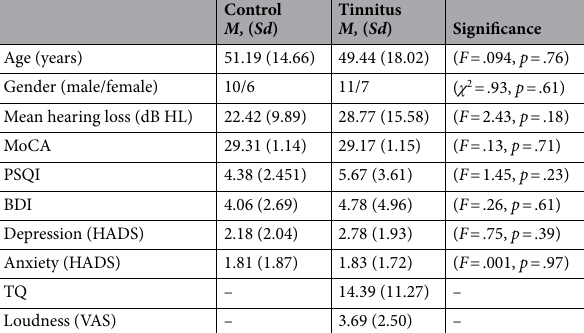
Table 1. Descriptive statistics and controlled